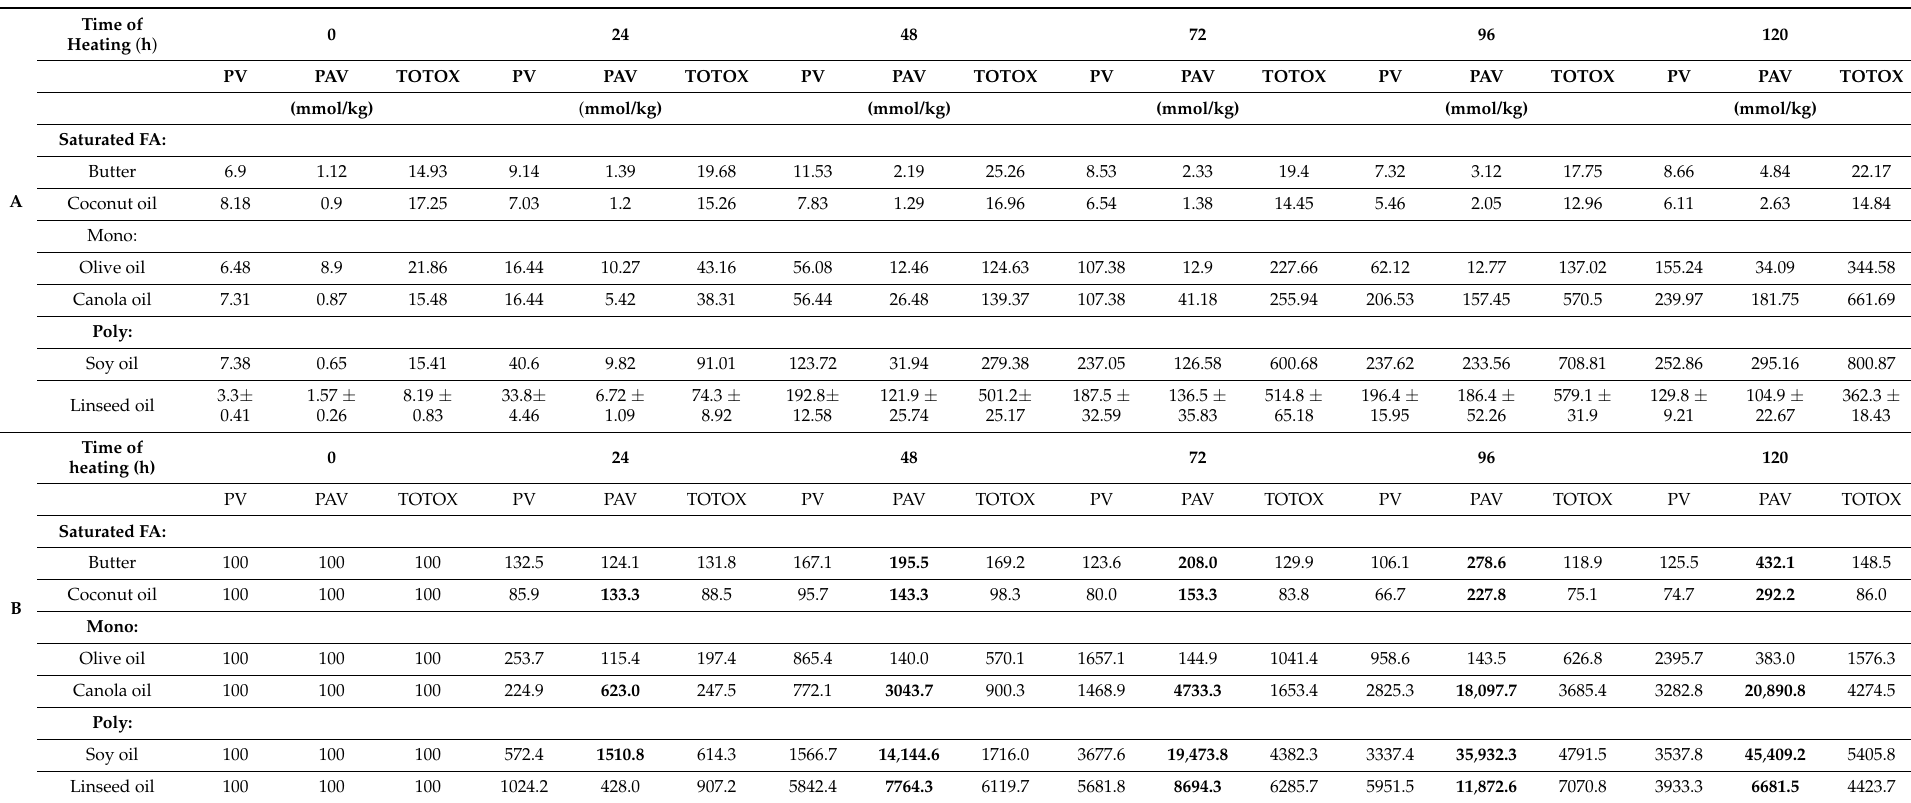
Table 1. Conventional analyses of rates of oxidation of saturated, mono-unsaturated, and poly-unsaturated edible oils during thermal oxidation at 80 ◦ C plus